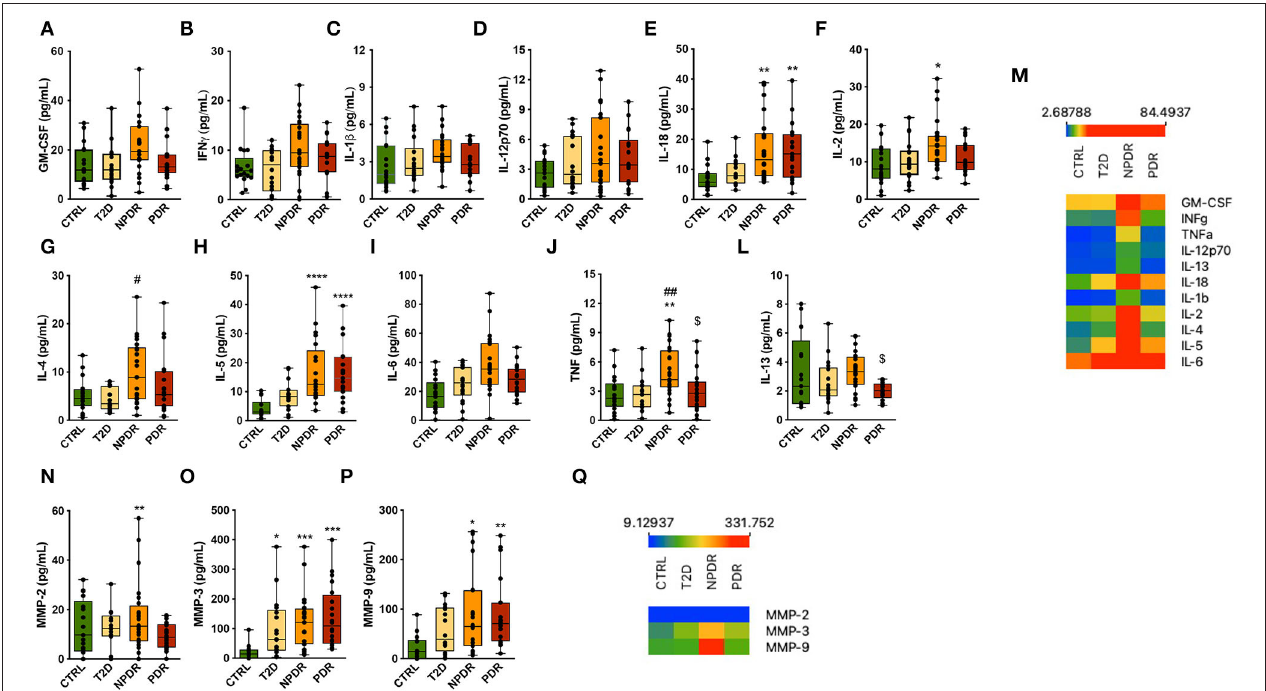
FIGURE 5 | Inflammation-related mediators in nondiabetic controls and T2D patients having no DR or with NPDR or PDR. (A–L) Th1- and Th2-type cytokines (GM-CSF, IFN γ , IL-1 β , IL-12p70, IL-18, IL-2, IL-4, IL-5, IL-6, TNF, IL-13) were measured in the tear fluid by multiplex immunoassays. The concentrations of IL-2, − 4, − 5, − 13, − 18 and TNF were significantly changed. Increased concentrations of IL-18 and IL-5 were found in NPDR and PDR groups compared to control group, and TNF and IL-2 were found to be increased only in NPDR group. IL-4 and TNF concentrations were also significantly increased in NPDR compared to T2D group. Interestingly, the concentrations of TNF and IL-13 were significantly decreased in PDR group compared to NPDR group. (M) Heatmap of the expression of Th1/Th2 cytokines across replicates among control group and diabetic subgroups. (N–P) Multiplex analysis of MMPs in tear fluid. The concentration of MMP-2 was higher in NPDR group compared to control group. Increased concentrations of MMP-3 and − 9 were also found in NPDR and PDR groups. MMP-3 concentration was found to be significantly increased in T2D group. (Q) Heatmap of the MMP’s expression across replicates among control group and diabetic subgroups . ( n = 17-26 samples/group; Kruskal-Wallis test; * p < 0.05, ** p < 0.01, *** p < 0.001 vs. CTRL. **** p < 0.0001 vs. Control, # p < 0.05 vs T2D, ## p < 0.001 vs